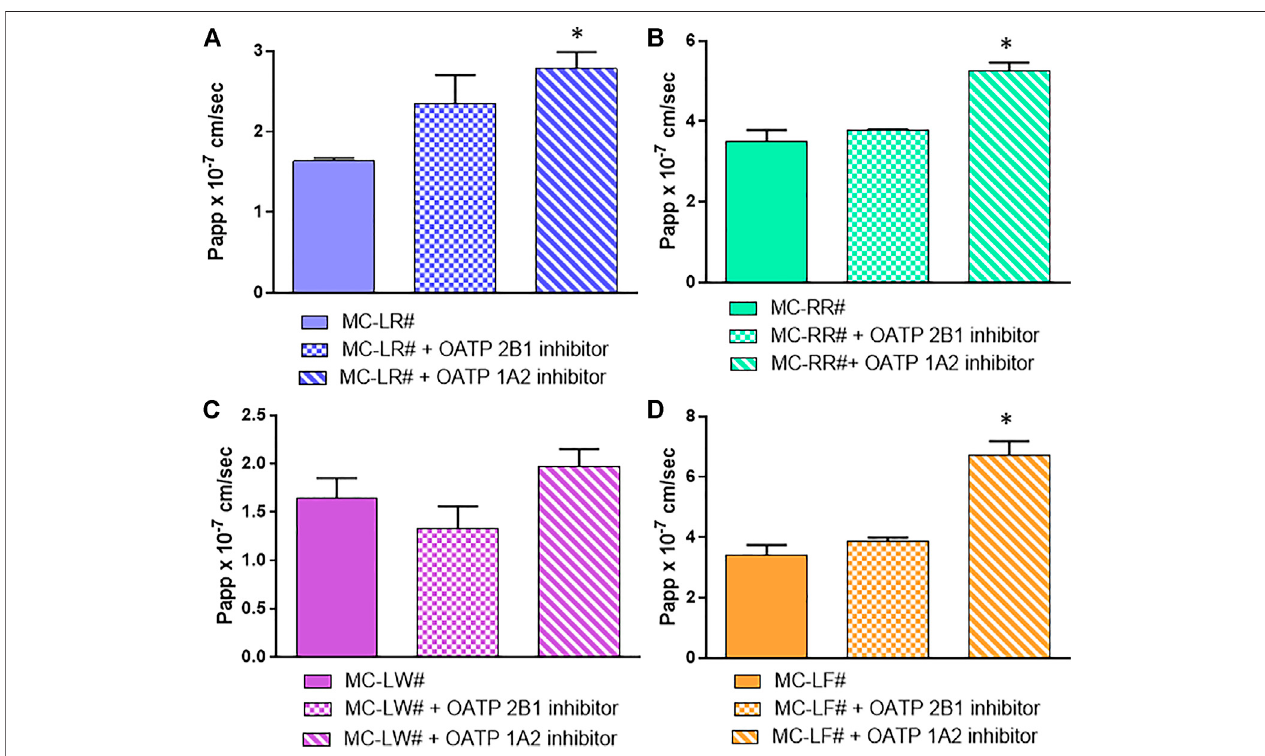
FIGURE 6 | Involvement of in fl ux protein in MCs absorption. (A) MC-LR (B) MC-RR (C) MC-LW and (D) MC-LF. Toxin concentration was 40 μ M; study duration was 4 h. The 3 bars in each section of the fi gure represent from left to right: Papp values of MCs in the presence of Digoxin plus Benzbromarone (as P-gp, MRP and BCRPinhibitors)setasthecontrol(#);controlmixturewith100 µMPravastatinasOATP2B1inhibitor;controlmixturewith50 µMNaringinasOATP1A2inhibitor.Atleast two independent experiments on different tissue lots from the same donor have been carried out, each in duplicates. Results are expressed as means ± standard deviations. Stars represent statistical signi fi cance of the results with p <